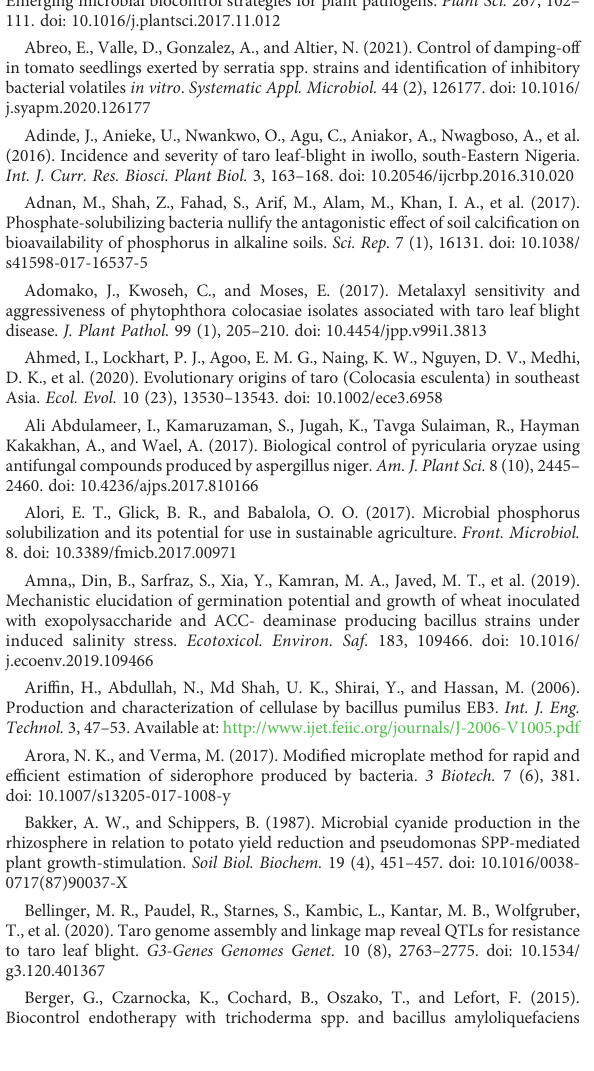
(A) Representative image showing inhibition of mycelial growth of P. colocasiae in cultures with cell free fi ltrate. The control culture showed uniform hyphal growth with the formation of numerous aerial hyphae, while the cell fi ltrate-enriched CMA inhibited radial hyphal growth of the pathogen. (B) Antagonistic activities of single or combined cell-free fi ltrates on P. colocasiae . Data are the means ± standard deviation. Means with different letters indicate a signi fi cant difference between the treatments according to Duncan ’ s multiple ranges at P ≤ 0.05